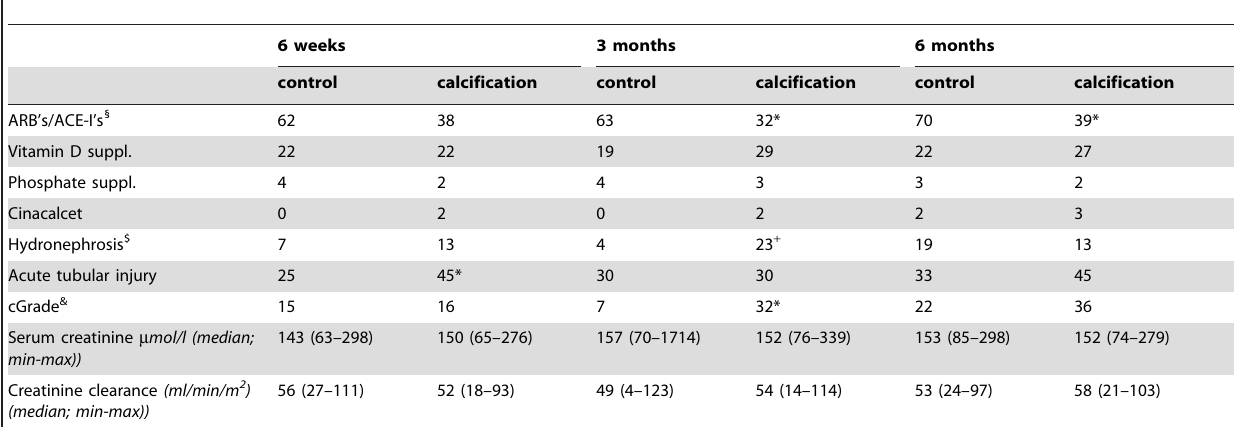
Table 2. Drug treatment and allograft status of patients and controls at biopsy time points.